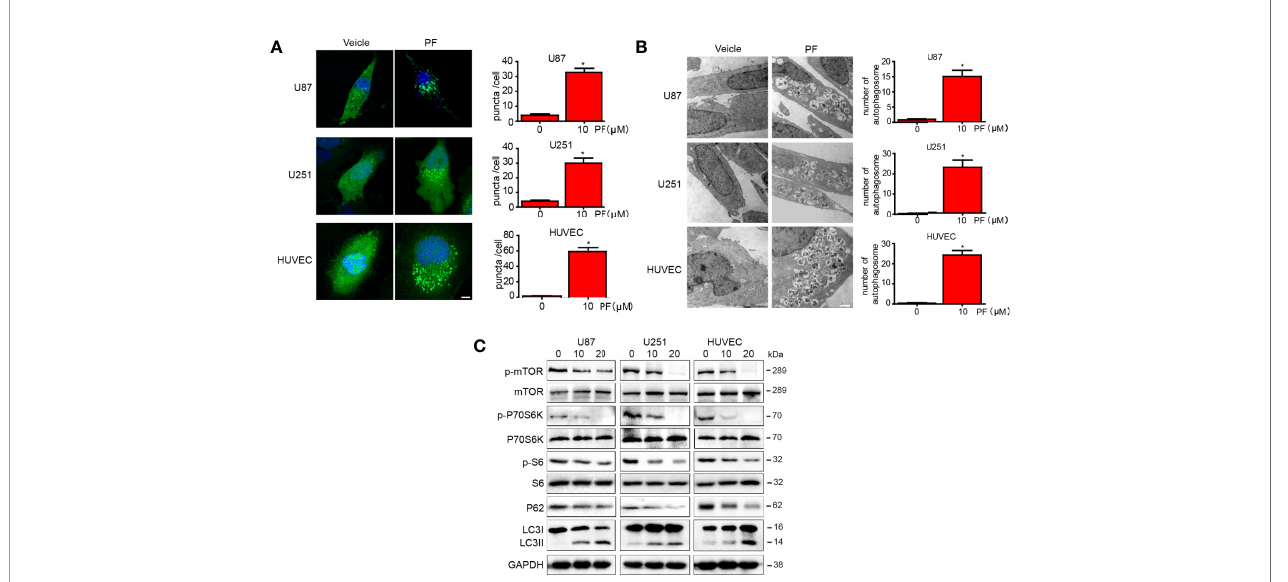
FIGURE 4 | Paeoni fl orin induced autophagy in glioblastoma cells and HUVECs. (A) U87 and U251 cells and HUVECs transfected with LC3-GFP plasmids for 24 hours were treated with the indicated concentration of paeoni fl orin for 12 hours and then imaged, and the numbers of punctate in each cell were counted. Bars, 7.5 m m. (B) U87, U251 cells and HUVECs were treated with the indicated concentration of paeoni fl orin for 12 hours, and then the cells were harvested before being analyzed by electron microscopy. The number of autophagosomes was counted. Bars, 1 m m. (C) U87, U251 cells and HUVECs were treated with the indicated concentration of paeoni fl orin for 24 hours, and then p-mTOR, p-P70S6K, p-S6 and LC3 and P62 protein expression was determined by western blotting. All tests were performed in triplicate, and the data are presented as the mean ± standard error. *P<0.05, compared with control (0